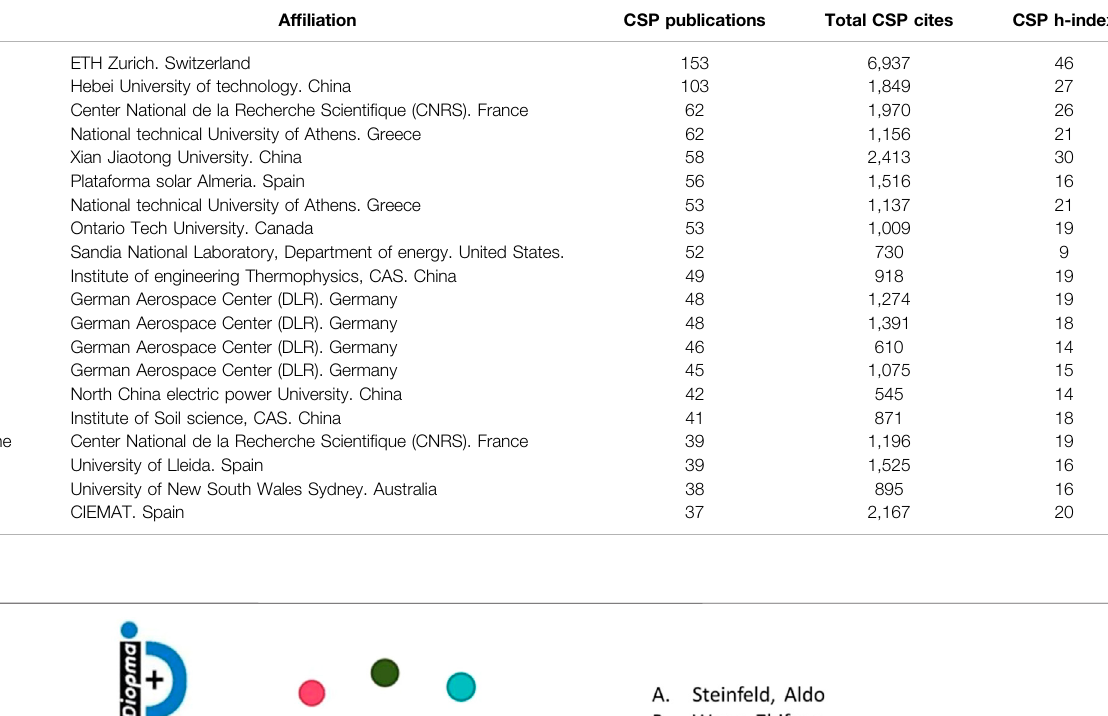
TABLE 5 | Top 20 authors in the CSP fi eld.